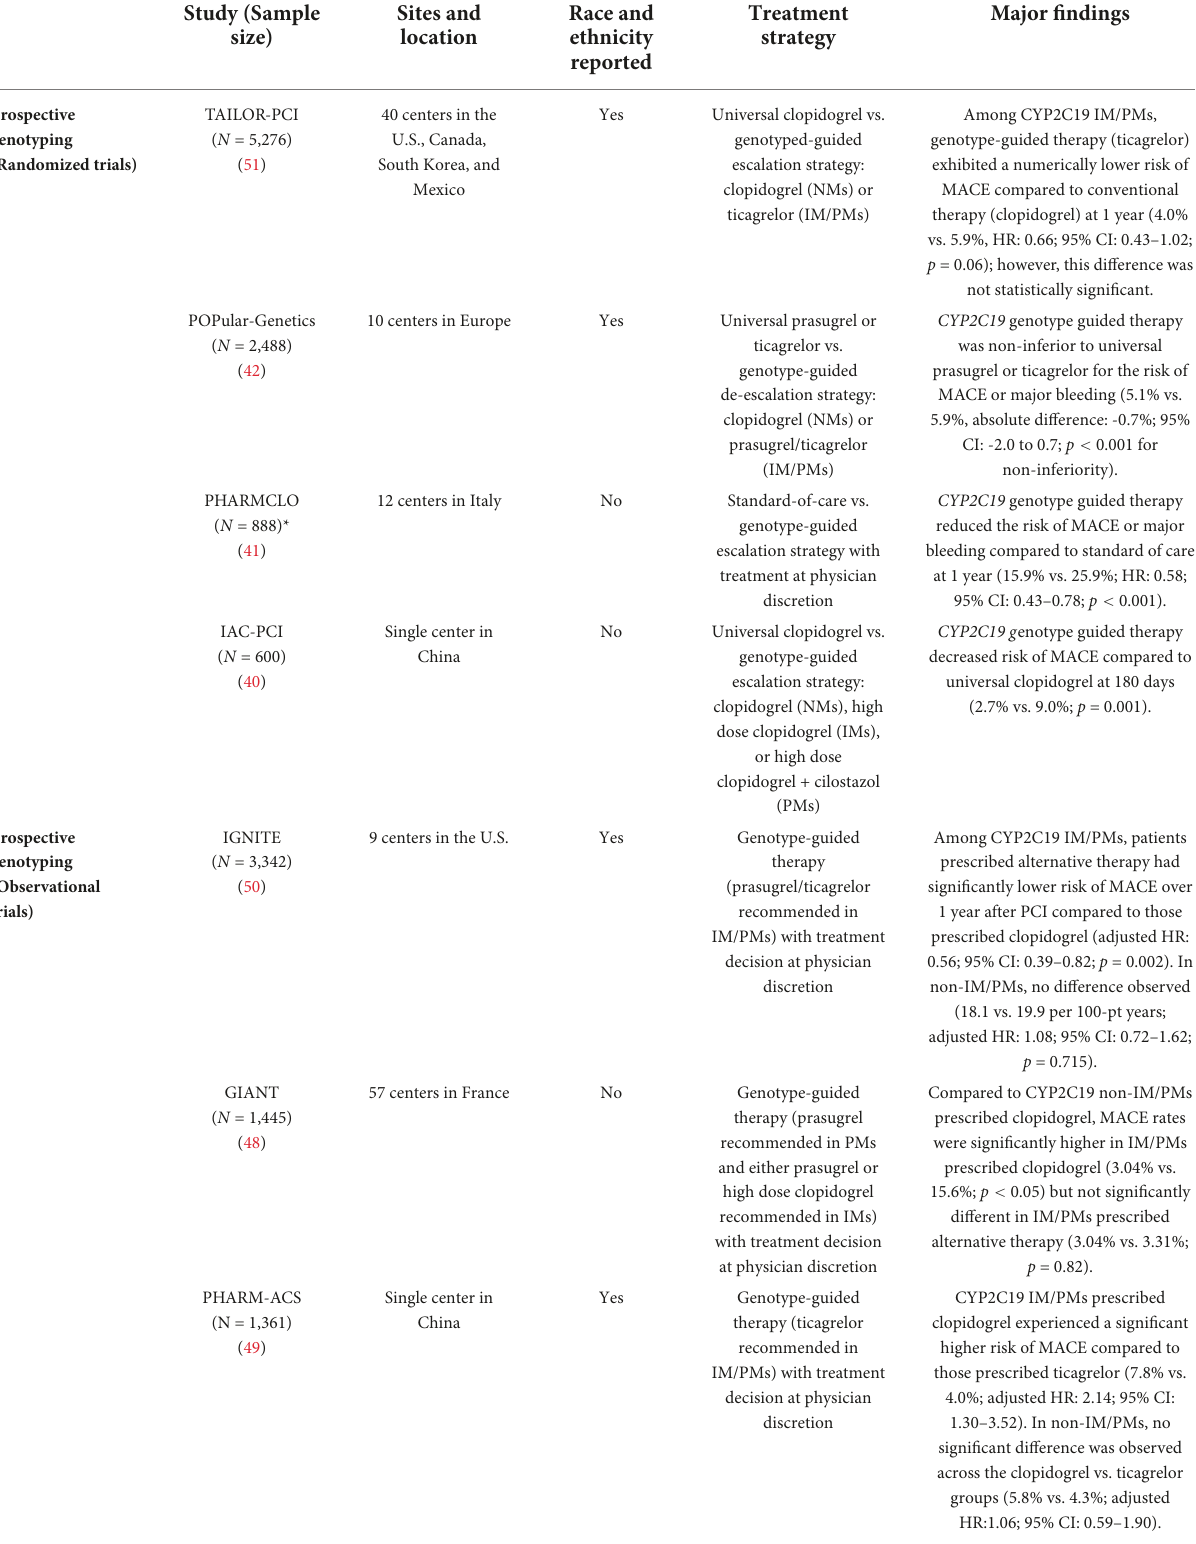
TABLE 1 Major prospective studies reporting clinical outcomes of CYP2C19 genotype-guided antiplatelet therapy after